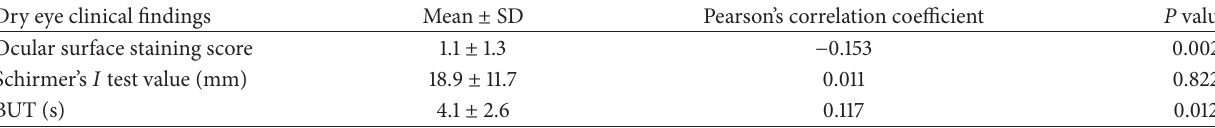
Table 3: Pearson’s correlation between International Physical Activity Questionnaire score and the clinical findings of dry eye disease.